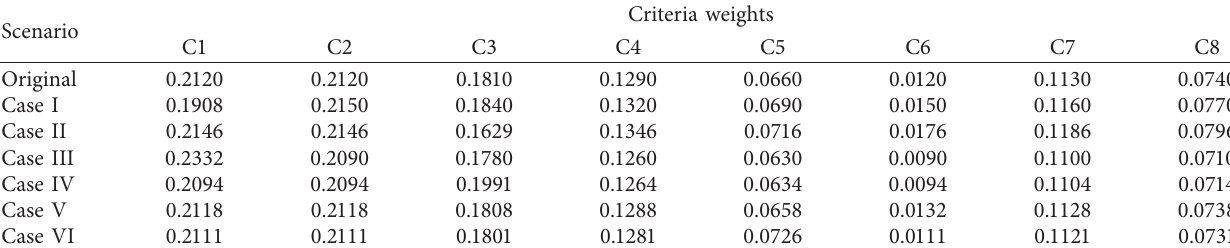
Table 16: Sensitivity analysis scenarios.